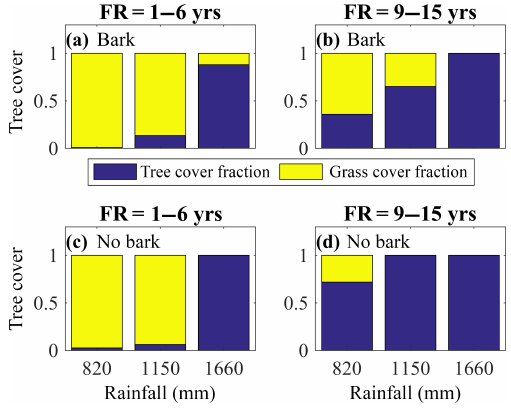
Figure 5. Bark investment can broaden the range of climate and fire conditions under which savannas occur by reducing the range of conditions leading to either complete tree loss or complete grass loss. Model-simulated tree cover fraction present at different levels of mean annual precipitation (in mm) for the model with bark (a– b) and the model without bark (c–d) for fire frequencies (FR) of 1–6 years (a, c) and 9–15 years (b, d) . Simulations were initialized with tropical tree and C 4 grass plant functional types and included a 100-year model spin-up from seedlings. The subsequent 20-year average tree cover fraction is